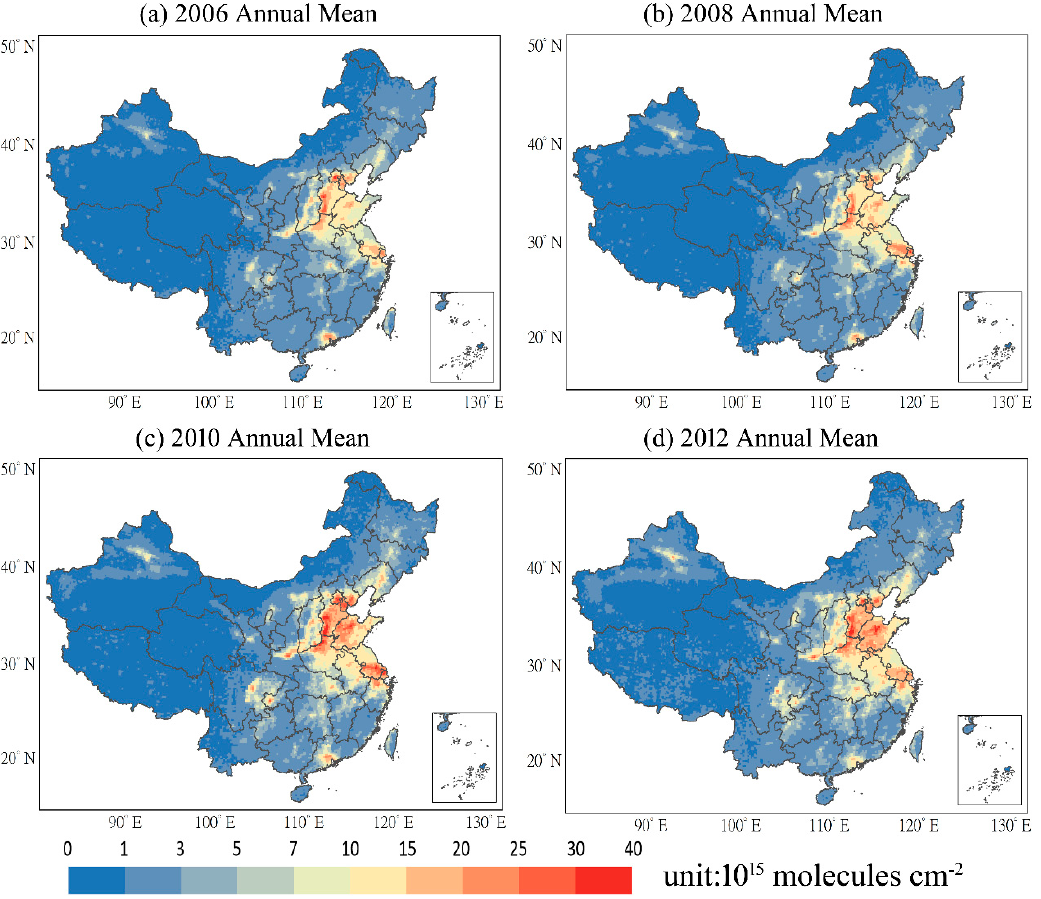
Figure 2. Global Moran’s I values at the city level from 2005 to 2012.